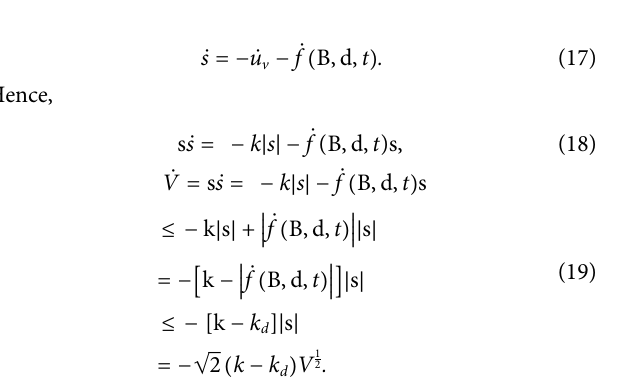
FIGURE 11 | Simulation block diagram of MR impact buffer sliding mode ADRC system with